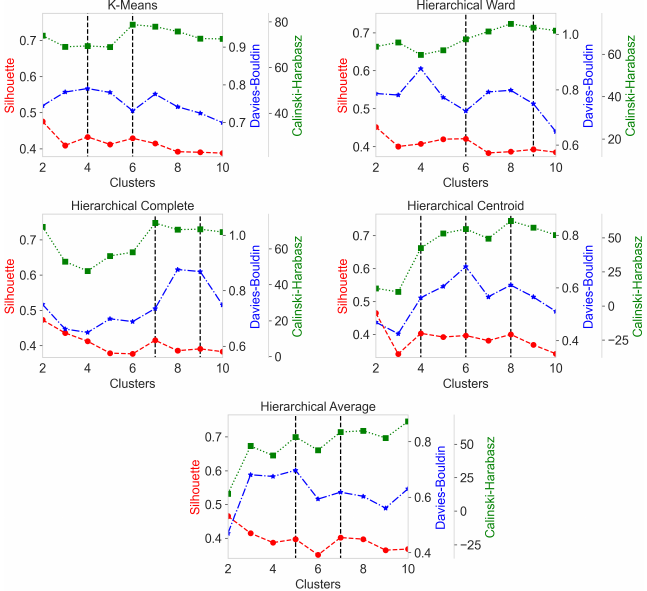
Figure 7. Variation in the Silhouette, Calinski–Harabasz and Davies–Bouldin validation index scores with respect to the number of clusters considered, for the K-means and hierarchical algorithms, with the ward, complete, centroid and average criteria for the